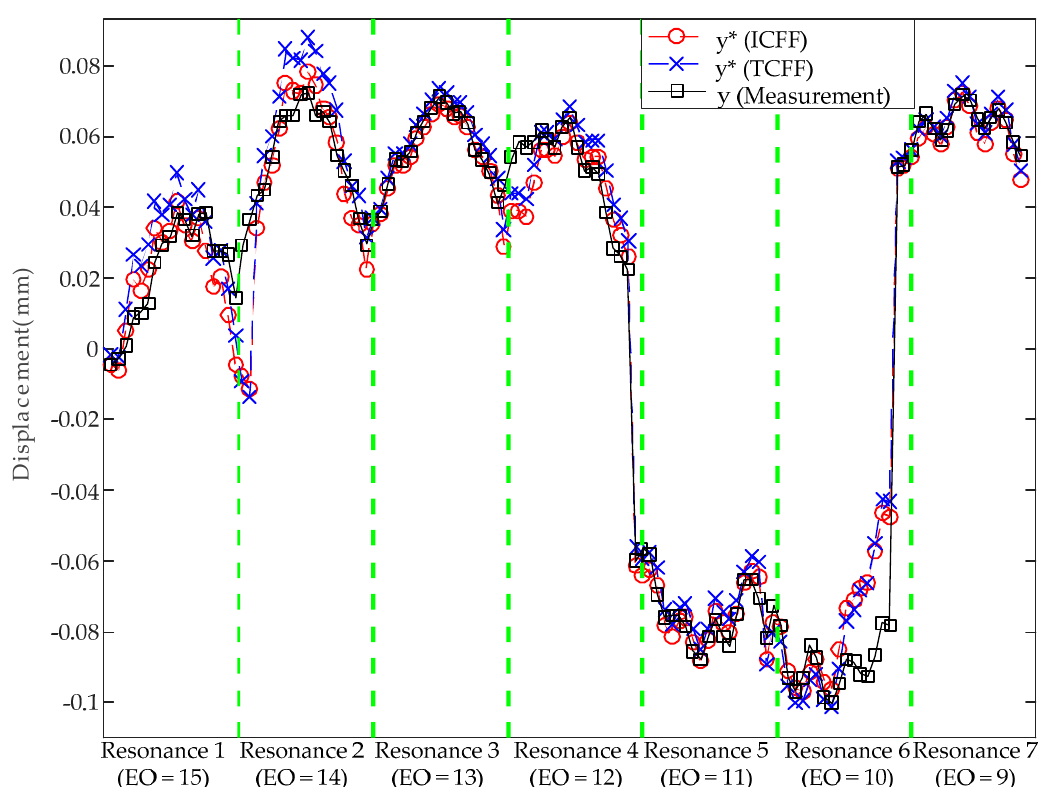
Figure 13. The reconstruction data of blade 7 measured by probe P 0. Table 5. The results of the identification.